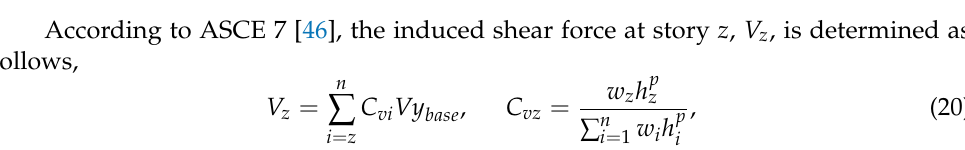
Figure 6. ( a ) MDOF models used in the study, ( b ) Story shear distribution along the height, ( c ) Story force-displacement relationship [34].